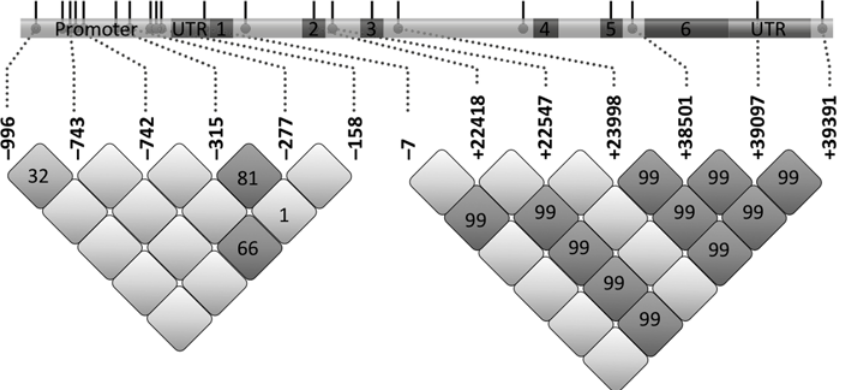
Fig 1. Distribution of polymorphisms and pair wise LD analysis (r 2 ) observed in COLEC10 . A schematic drawing of the gene COLEC10 is given at the top. Exons are numbered and promoter and non- translated regions are indicated. The numbers in the grid refer to the r 2 values of a given pair of SNPs. Darker colours of the boxes means higher r 2 values.